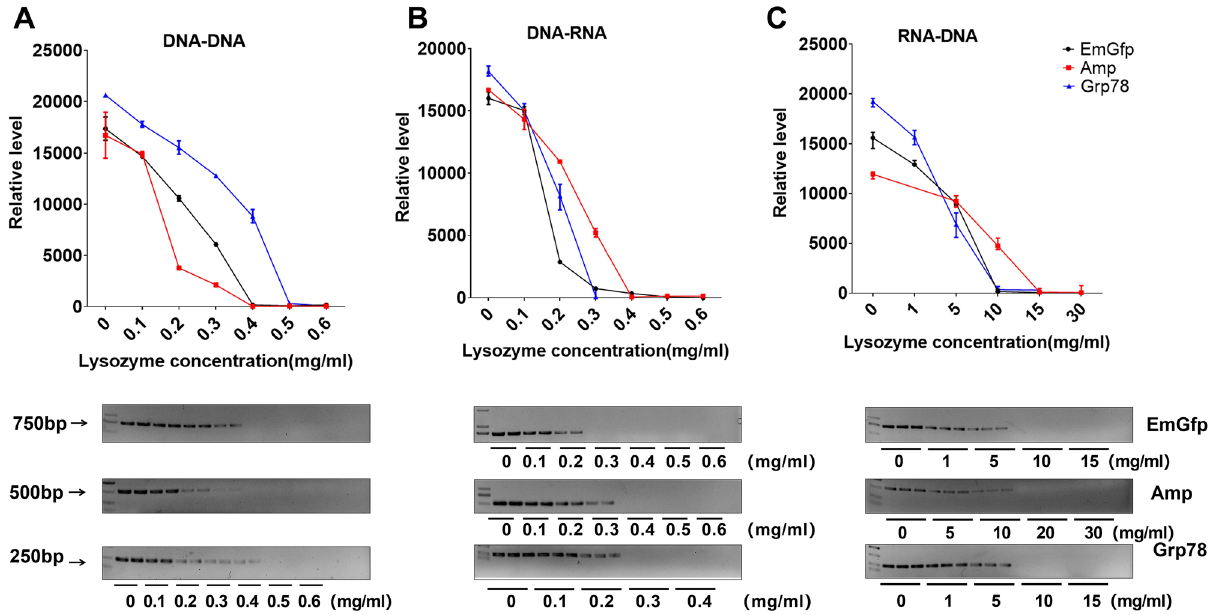
Figure 2. Cell lysate-treated lysozyme blocks EmGfp, Amp and Grp78 DNA replication, transcription and reverse transcription. ( A )–( C ) Gel electrophoresis of PCR products. Cell lysate-treated lysozyme at the corresponding working concentration was added to the reaction system: ( A ) replication, ( B ) transcription and ( C ) reverse transcription. Intensity analysis of target bands in gel electrophoresis is shown at the top of the blot. Data are representative of 2 independent experiments and presented as the mean ± SD; * p < 0.05, *** p < 0.001. Significant differences were evaluated using one-way ANOVA with a post hoc test (Fisher’s least significant